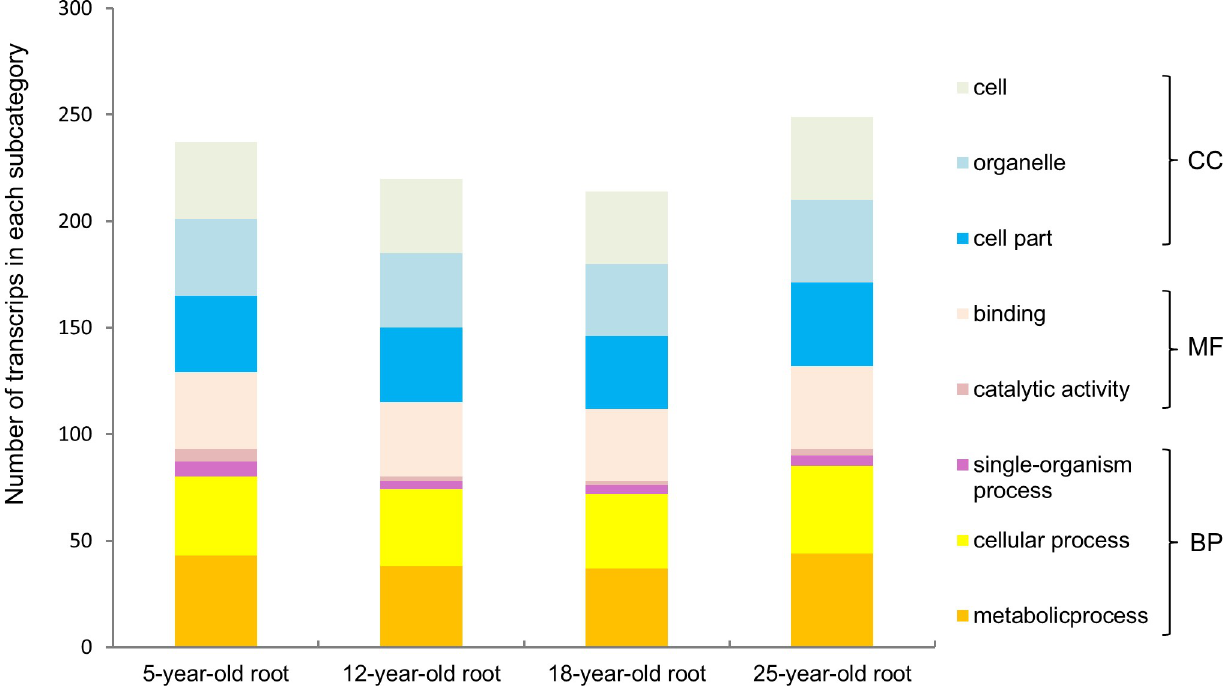
Fig 6. Variation of the functional categorization of the PgNAC transcripts among the roots of 5-, 12-, 18- and 25-year-old plants.